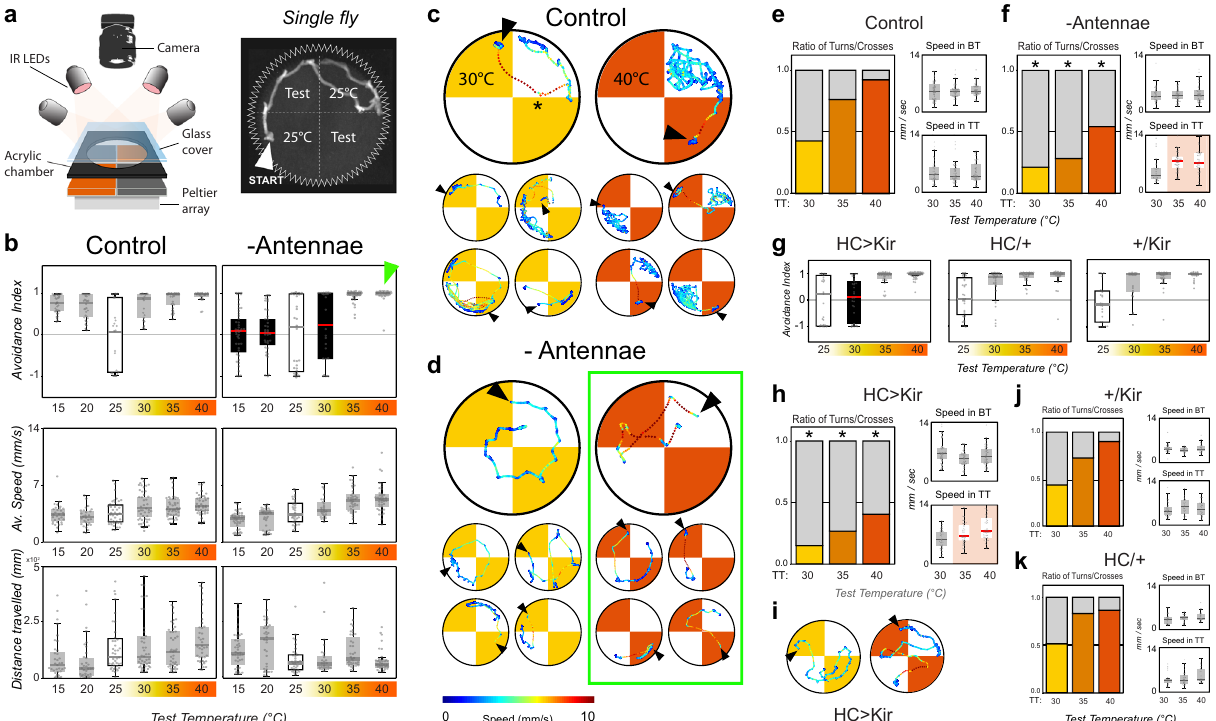
Fig. 2 Thermosensory neurons of the arista guide rapid navigation during thermotaxis. a Schematic representation of the single fl y 2-choice assay for temperature preference. (Test = test temperature). b Avoidance indexes and locomotory parameters of (left) single wild-type control fl ies and (right) single fl ies in which the antennae had been surgically removed at eclosion. (Top row) Avoidance indexes. Antenna ablated fl ies display no avoidance for test temperatures ranging from 15 to 30 °C (a solid red median line denotes a signi fi cant difference between experimental and controls, ANOVA: P 15 = 1.1e − 7, P = 3.7e − 6, P = 2.3e − 2; a black box denotes avoidance indexes not different from zero, one-sample t test, P > 0.05). (Center and Bottom row) 20 30 Quanti fi cation of locomotor parameters shows that antenna ablation does not produce major defects in motility (WT: N 15 = 27, N 20 = 26, N 25 = 43, N 30 = 55, N 35 = 53, N 40 = 55, Ablated: N 15 = 43, N 20 = 36, N 25 = 32, N 30 = 26, N 35 = 38, N 40 = 38). c , d Single representative tracks from control and antenna- ablated fl ies. c Control fl ies avoid hot quadrants by producing sharp U-turns at cool/hot boundaries (asterisk; note that in all panels arrowheads denote the position of each fl y at the start of heating, and that tracks are color-coded by speed). d Antenna ablated fl ies fail to systematically produce sharp U-turns and instead frequently invade the hot quadrants. e , f Quanti fi cation of the ratio of U-turns/border crosses at the cool/hot boundaries and associated locomotor parameters (Ns as in ( b )). e In control fl ies the ratio of U-turns/border crosses increases as a function of the temperature on the hot side, until (for test temperature = 40 °C) most border interactions result in U-turns. f Antenna-ablated fl ies display signi fi cantly smaller fractions of U-turns at the border in all conditions, but instead display a higher speed for traversals of the 35 °C and 40 °C hot quadrants (highlighted in the lower right panel in ( f ), BT base temperature, TT test temperature). g – i Genetic silencing of hot-activated TRNs of the arista results in phenotypes in the hot range very similar to antenna ablation (HC/Kir: N 25 = 29, N 30 = 33, N 35 = 36, N 40 = 46, HC/ + : N 25 = 27, N 30 = 22, N 35 = 29, N 40 = 26, Kir/ + : N 25 = 35, N 30 = 32, N 35 = 26, N = 26; 2-way ANOVA: P = 1.3e − 3). j , k Control genotypes (drivers and effectors). In all boxplots, the edges of the boxes are the fi rst and third 40 30 quartiles, a solid line marks the median, and whiskers delimit the data range; In ( f – k ), a solid red median line denotes a signi fi cant interaction between experimental and control animals, a black box denotes avoidance indexes not signi fi cantly different from zero. Asterisks in ( f ) and ( h ) denote signi fi cant differences in turn/cross ratios from the appropriate controls (asterisk in ( f ): GLMM, Wald test: vs Control P 30 = 3.3e − 2, P 35 = 6.4e − 11, P 40 = 6.5e − 6; red line in ( f ): ANOVA, P 35 = 2.1e − 5, P 40 = 5.1e − 6, control ( e ); asterisks in ( h ): 2-Way GLMM, Wald test: P 30 = 2.3e − 3, P 35 = 1.6e − 6, P 40 = 3.0e − 2; red